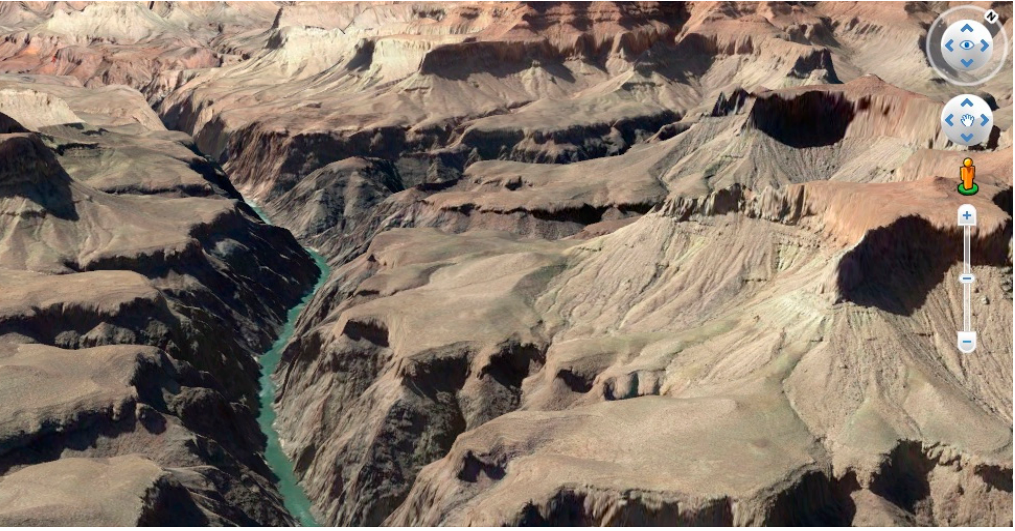
Figure 9. Image of Grand Canyon. Arizona. From “Google